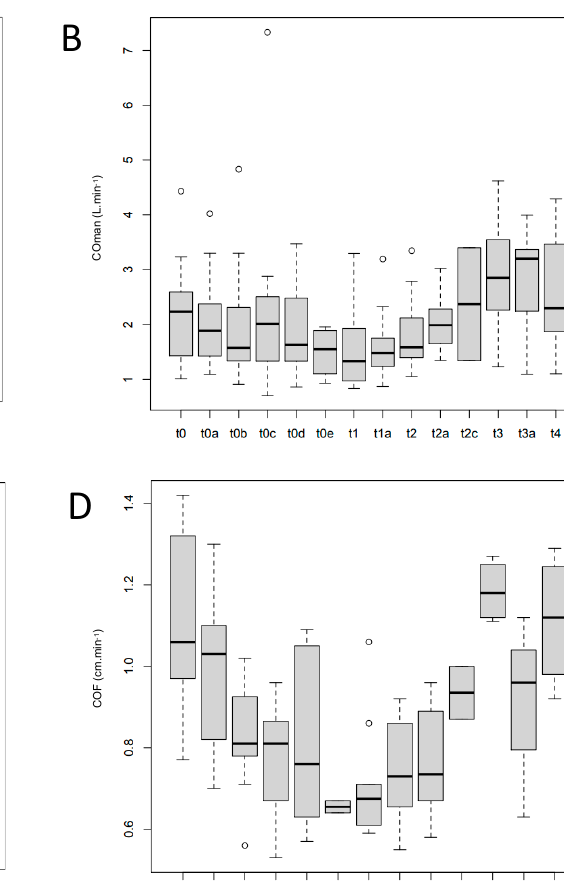
Figure 2. Feasibility according to the experimental time of manually measured sub-aortic velocity